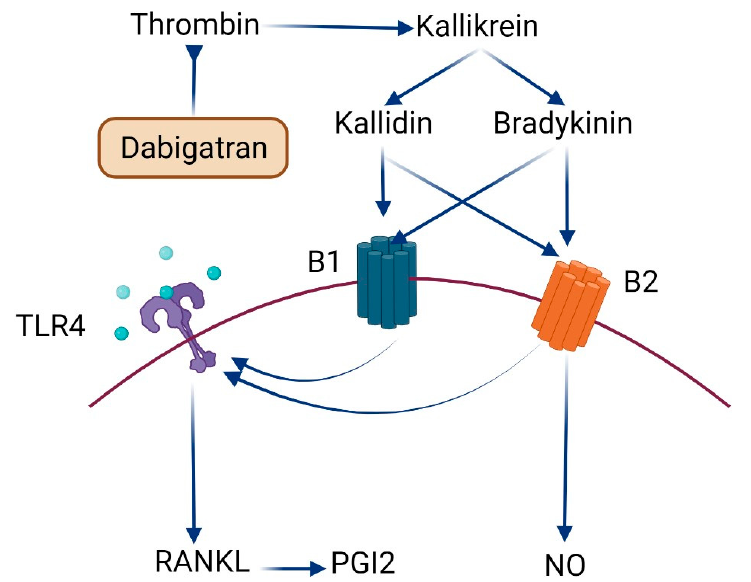
Figure 6. Schematic illustration summarizing the anti ‐ inflammatory/antiarthritic roles of